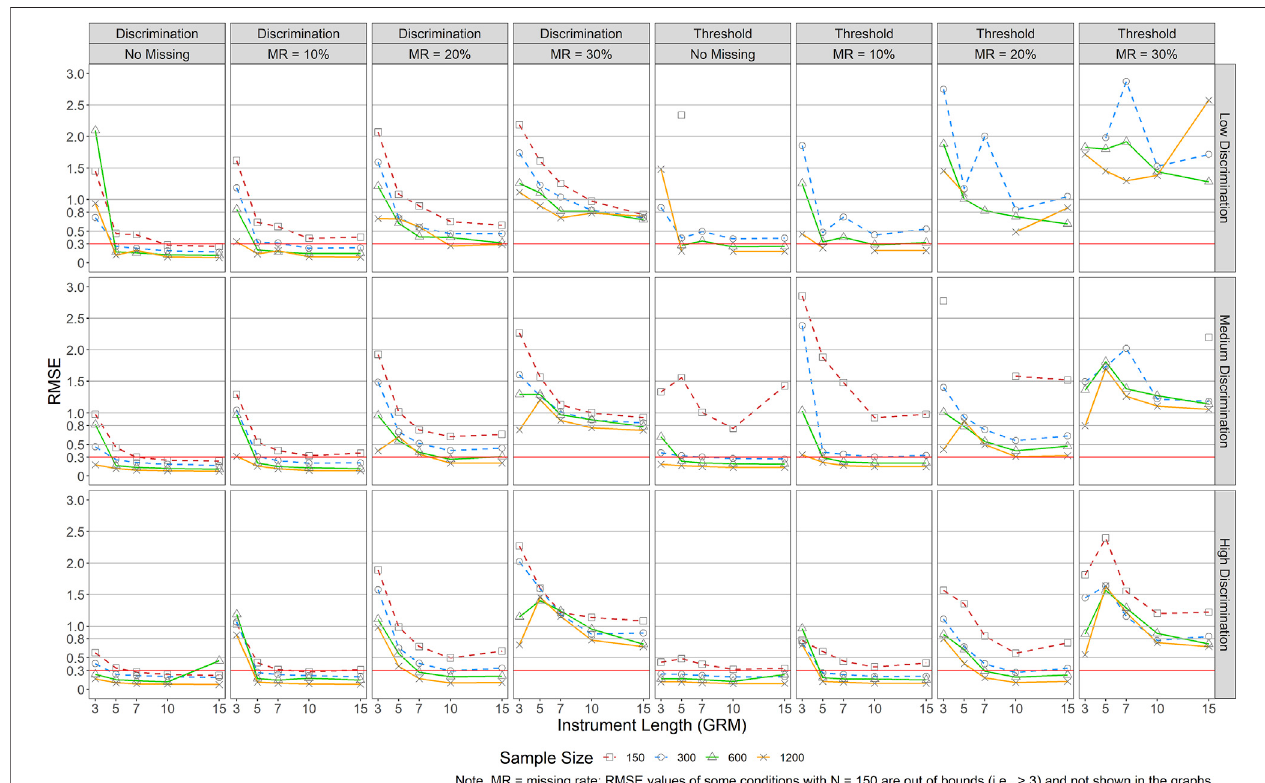
FIGURE4| RMSEofItem Parameter EstimationsforGRM. Note. MR (cid:1) missingrate;RMSEvaluesofsomeconditionswithN (cid:1) 150areoutofbounds (i.e., > 3)and not shown in the